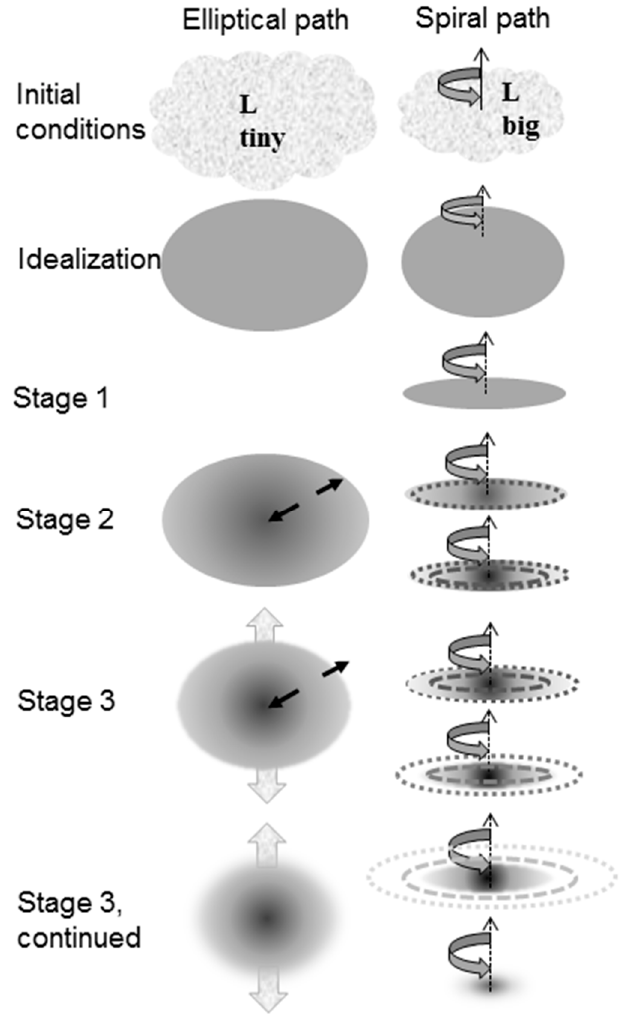
Figure 11. Schematic of largely conservative galactic evolution. Top row = giant precursor clouds. The data suggest clouds for spirals were smaller. Second row = homogenous density oblates assumed to provide analytic solutions. Third row (Stage 1) = pancaking, but only of the coherently spinning clouds. Fourth row (Stage 2) = conservative contraction which densifies the interior and in spirals produces the organized structures, shown here as rings, which also represent the arms. Fifth and sixth rows (Stage 3) = contraction and round up with mass loss. For the spirals, the arms dissipate. For ellipticals, either the outer layers diffuse or jets are produced, which carry away kinetic energy and mass, allowing angular moment and energy to be conserved. Because radial symmetry is presumed, this evolutionary sketch does not show the lower symmetry aspects of bars and arms.